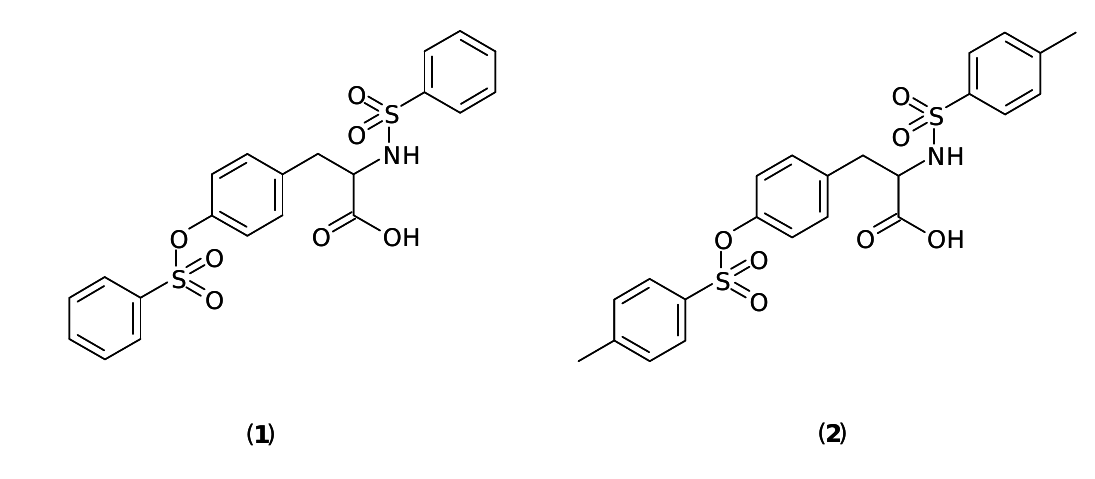
Figure 1. Structures of 1 and